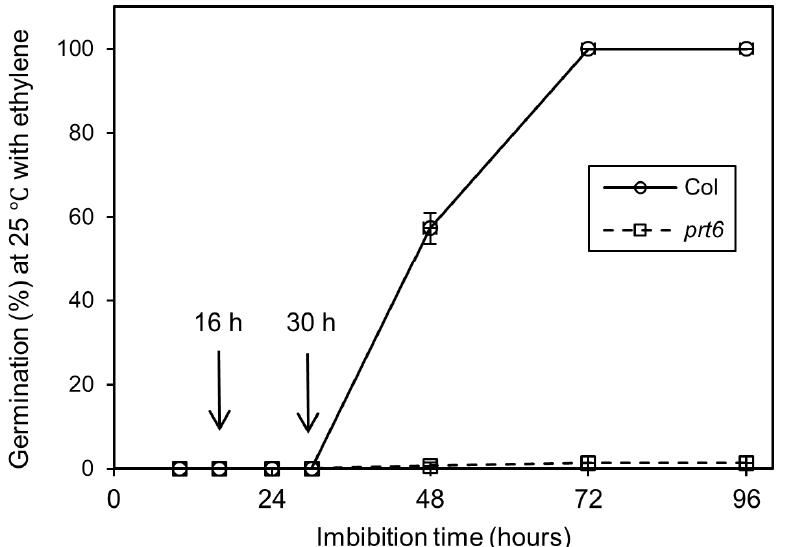
Figure 1. Germination percentages obtained with Col and prt6 seeds placed at 25 ◦ C on water in the presence of ethylene at 100 µ L L − 1 . Means of 3 replicates ± SD. Seeds harvested in 2016. The arrows indicate the sampling time used for label-free quantitative analysis. Table 1. Effects of the duration of incubation at 25 ◦ C in the presence of ethylene at 100 µ L L − 1 on subsequent germination of dormant Col seeds after transfer in air at 25 ◦ C. Means of 3 replicates ± SD Seeds harvested in 2016 and